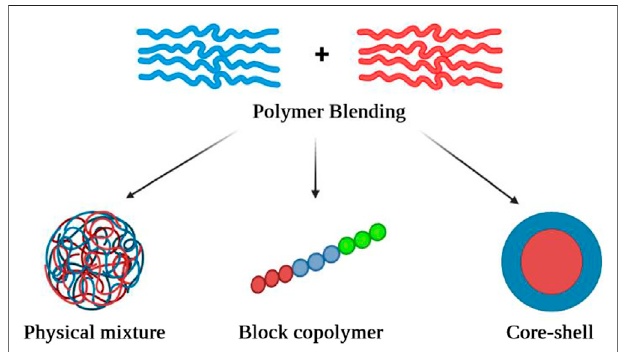
FIGURE 1 | A schematic view of different polymer blending approaches including physical mixture, block copolymer, and core-shell model.